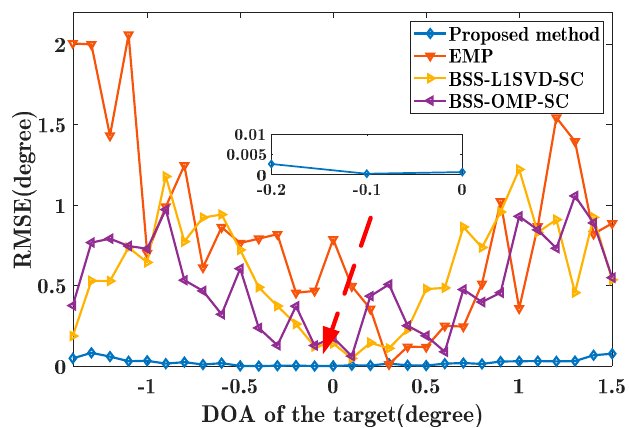
Figure 11. The DOA estimation of the target.